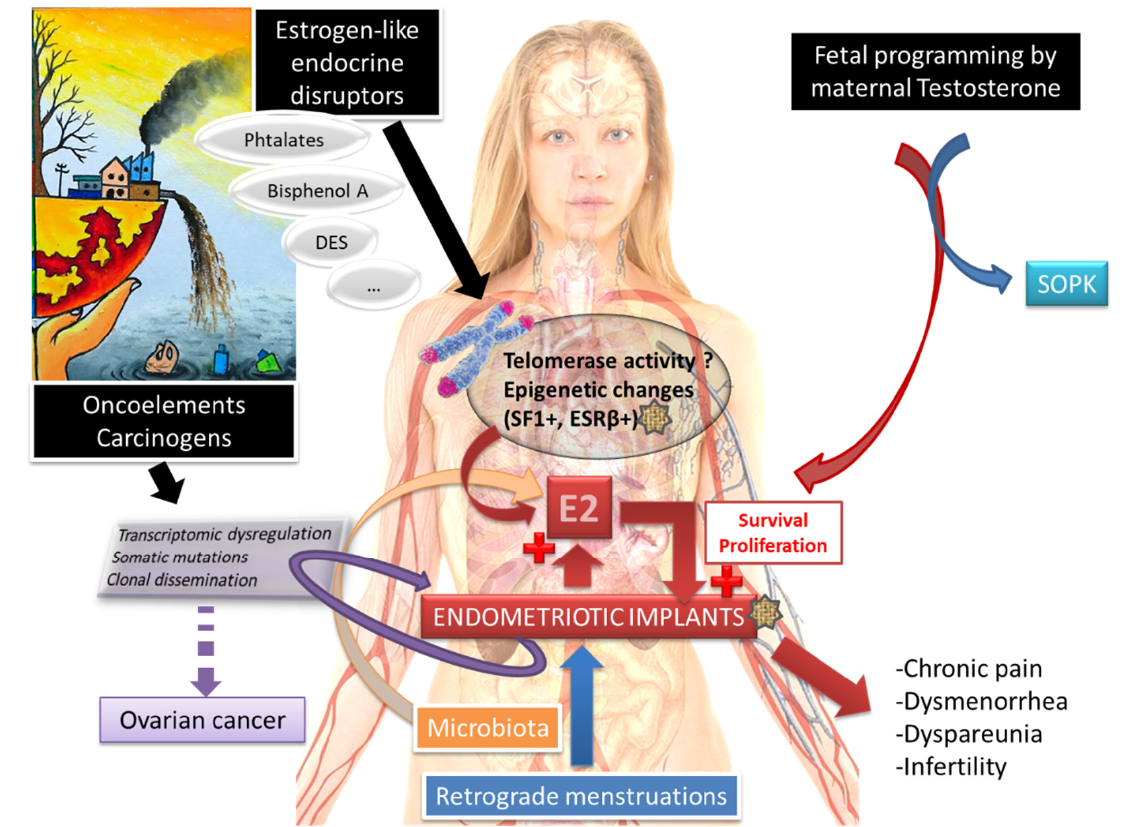
Figure 5. Endometriosis, a complex disease, with several concomitant etiologies? Further large-scale and homogeneous studies are needed to draw conclusions about the Epidemiological studies of exposure to the molecules probably involved in such a influence of these endocrine-disrupting compounds on the development of mechanism, such as dioxins, bisphenol A, phthalates, DES, or nicotine, have not found strong and repeatable correlations. However, these studies are conducted using heteroge- neous methodologies. Measurement errors in estimating the behaviors during pregnancy of mothers of daughters suffering from endometriosis can hinder the results obtained be- cause of “subjectivity” and recall bias. All the abovementioned studies are not based on the same clinical diagnosis repositories of endometriosis because they were not performed at the same time. Selection bias could have occurred. In addition to classification errors, all of these aforementioned elements constitute an important limitation [10,66].